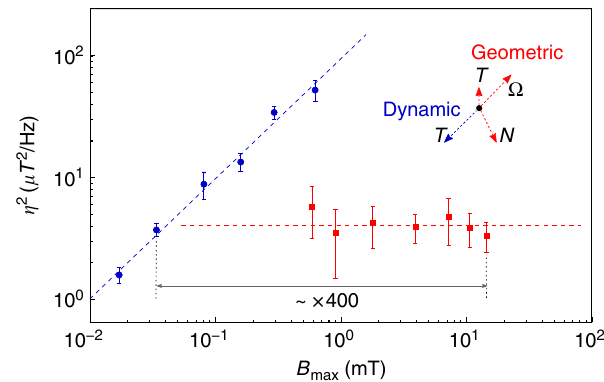
Fig. 3 Decoupling of magnetic fi eld sensitivity and maximum fi eld range. Measured performance of dynamic-phase (blue dots) and geometric-phase (red squares) magnetometry. Dashed lines are linear fi ts to data. Dashed arrows indicate the orientation of control parameters Ω , N , T as independent vectors on the ( η 2 , B max ) map. Since a Ramsey sequence used for dynamic-phase magnetometry has only a single control parameter ( T ), the relations for sensitivity ( η ∝ T 1/2 ) and fi eld range ( B max ∝ T − 1 ) are unavoidably coupled as η 2 ∝ B max . In contrast, a Berry sequence used for geometric-phase magnetometry employs all three control parameters, and thus the sensitivity ( η ∝ Ω − 1 N T 1/2 ) can be chosen independently of the fi eld range ( B ∝ Ω N 1/2 T 0 ). For example, larger B η is m ax max with constant obtainable with geometric-phase magnetometry by increasing Ω and N while keeping T and the ratio Ω / N fi xed. Error bars represent one standard deviation of the